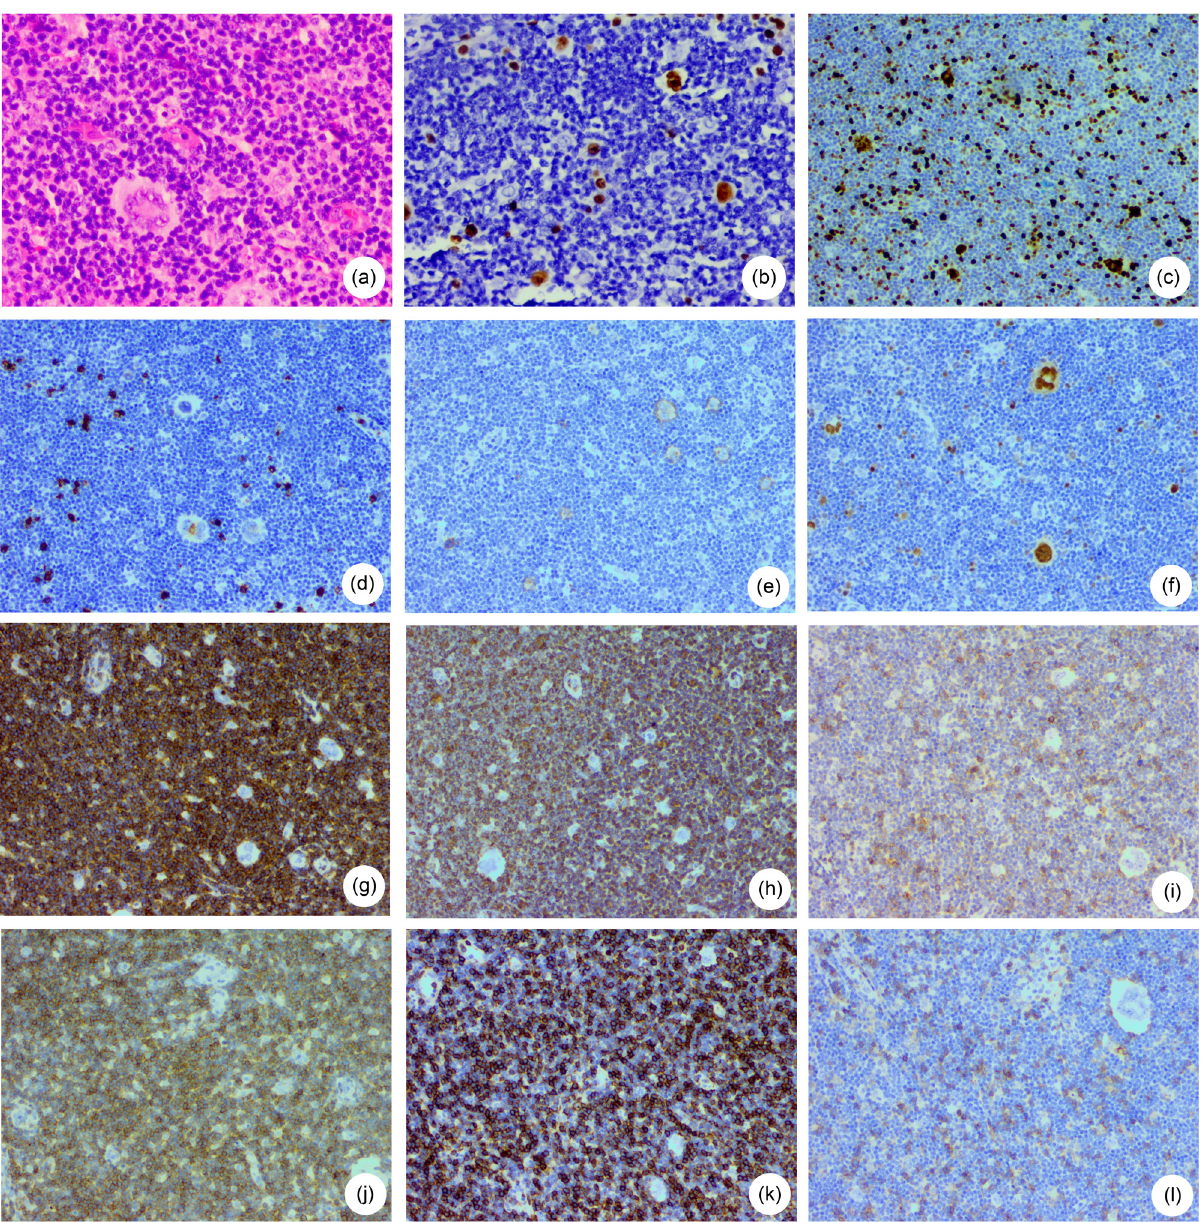
Figure 1: Histopathological fi ndings of the lymph node biopsy performed on case 1 showing ( a ) R – S cells and scattered small T - lymphoid cells ( hematoxylin and eosin, 200 ×) , ( b ) EBER staining by in situ hybridization ( 100 ×) , ( c ) R – S cells and T - lymphoid cells ( 40% ) showing positive Ki - 67 immunoreactivity ( 100 ×) , ( d ) R – S cells showing weak CD15 immunoreactivity ( 100 ×) , ( e ) R – S cells showing weak CD30 immunoreactivity ( 100 ×) , ( f ) R – S cells showing positive MUM - 1 immunoreactivity ( 100 ×) , ( g ) T - lymphoid cells showing positive CD2 immunoreactivity ( 100 ×) , ( h ) T - lymphoid cells showing positive CD3 immunoreactivity ( 100 ×) , ( i ) T - lymphoid cells showing positive CD5 immunoreactivity ( 100 ×) , ( j ) T - lymphoid cells showing weak CD7 immunoreactivity ( 40 ×) , ( k ) T - lymphoid cells showing weak CD7 immunoreactivity ( 100 ×) and ( l ) T - lymphoid cells showing positive CD8 > CD4 immunoreactivity ( 40 ×)